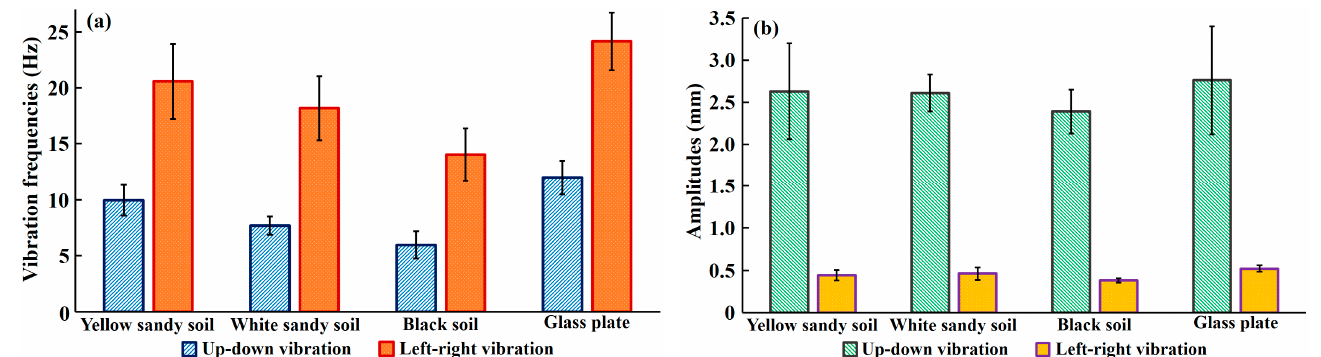
Figure 3. Statistics of the up–down and left–right vibration parameters of the antlions in four conditions: ( a ) Vibration frequencies; ( b ) Amplitudes.